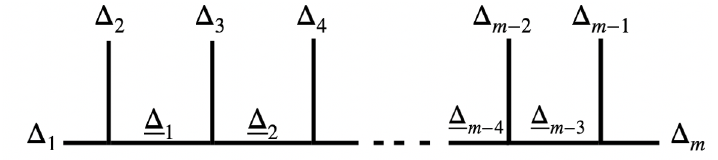
Figure 3 . On the above diagram chiral vertex operators with external conformal weights ∆ := { ∆ 1 , . . . , ∆ m } have the following locations, V ∆ x m − 2 = 1 and V ∆